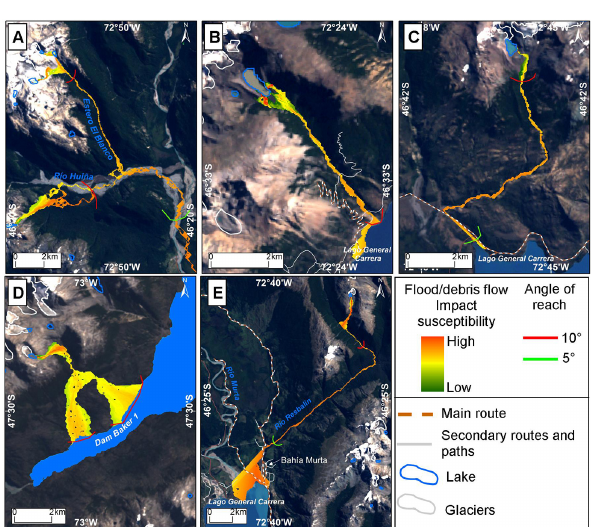
Figure 14. GLOF modelling from lakes with high or very high out- burst susceptibility closest to inhabited zones. Forestry land, routes and a planned dam are in the path of potential debris flows (angle of reach ≥ 10 ◦ ) and floods. The flow width in D is probably exag- gerated in its unchannelized